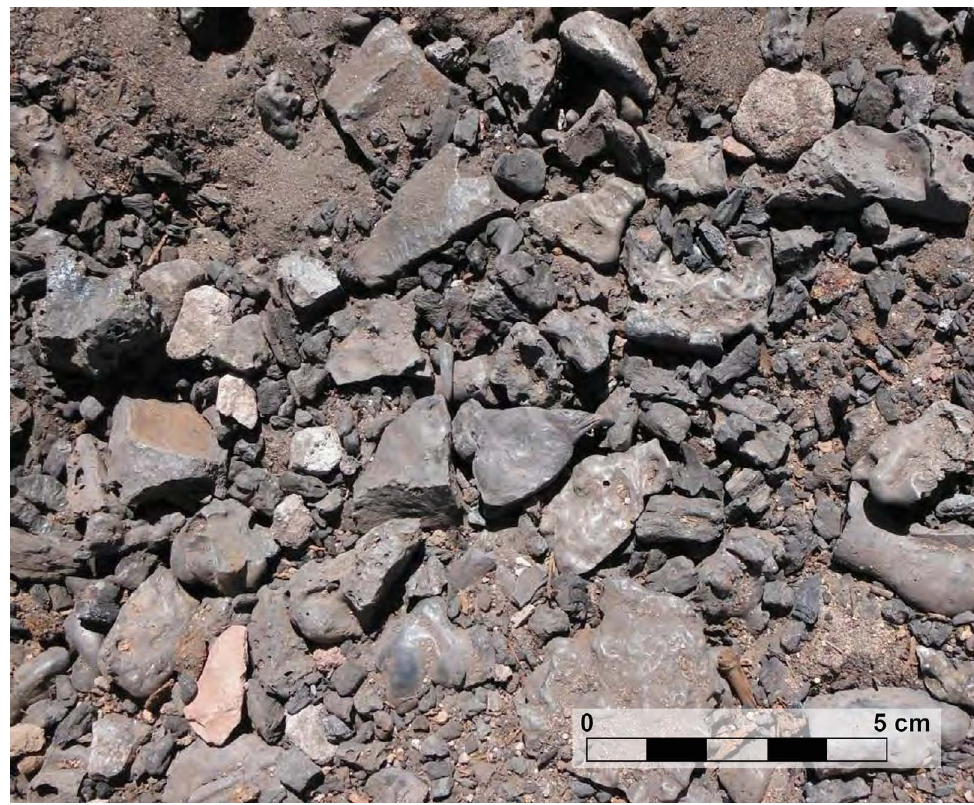
Figure 26. Crushed slag fragments from Site